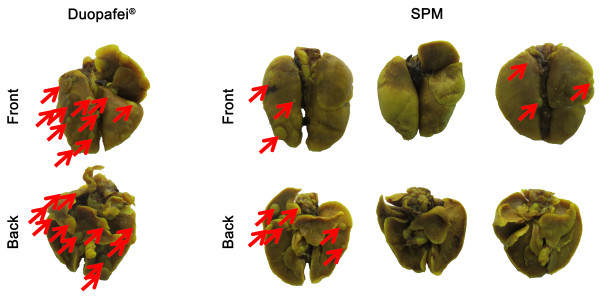
Lung histology in the Duopafei- and SPM- treated groups. Lungs were immersed in Bouin’s fixative for 24 h. Red arrow indicates the metastatic nodule on the lung.